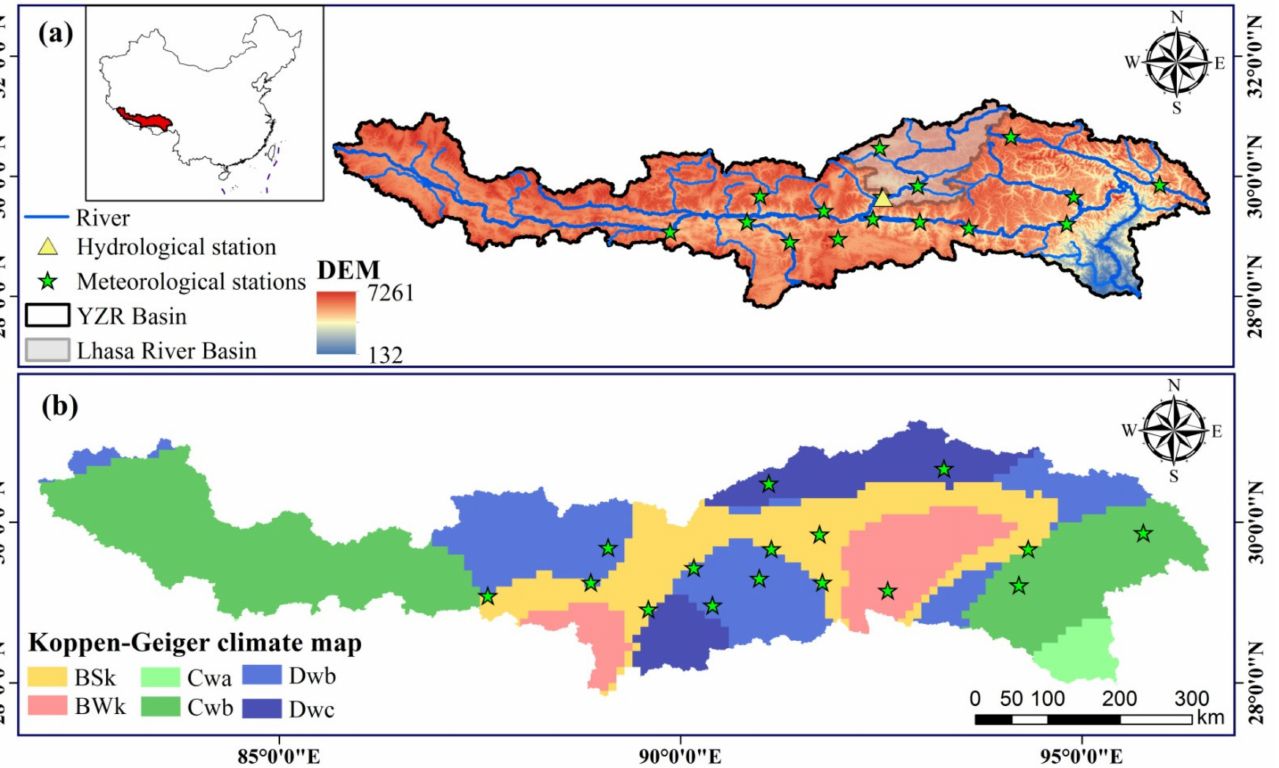
Figure 1. The location of Yarlung Zangbo River Basin: ( a ) mainly represents the distribution of mete- orological and hydrological stations in the basin, as well as elevation changes, while ( b ) represents the difference in climatic zones within the